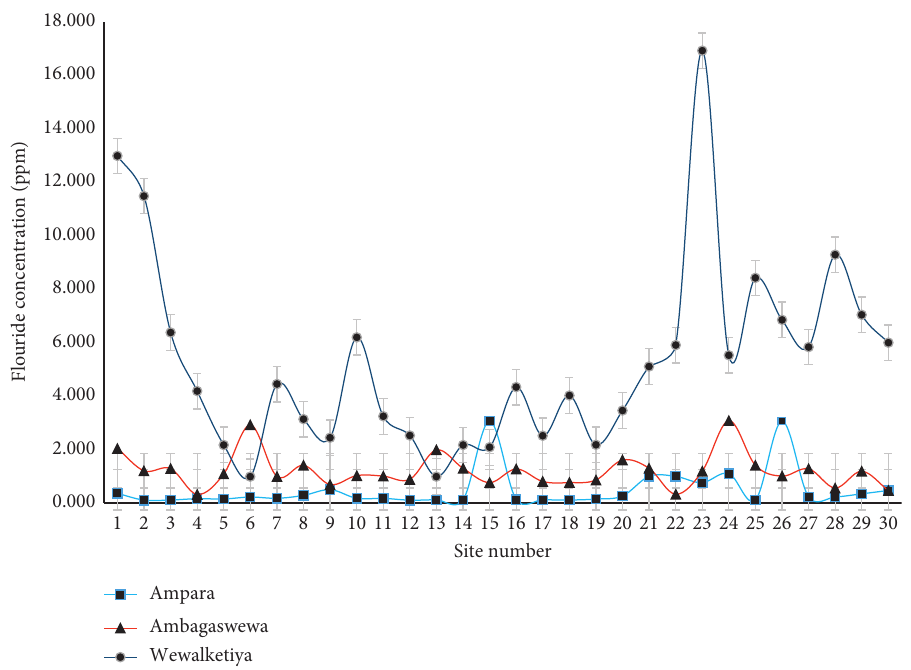
Figure 3: Variations of fluoride concentrations along the sampling points in the reference site (Buddangala) and disease prevalence areas (Ambagaswewa and